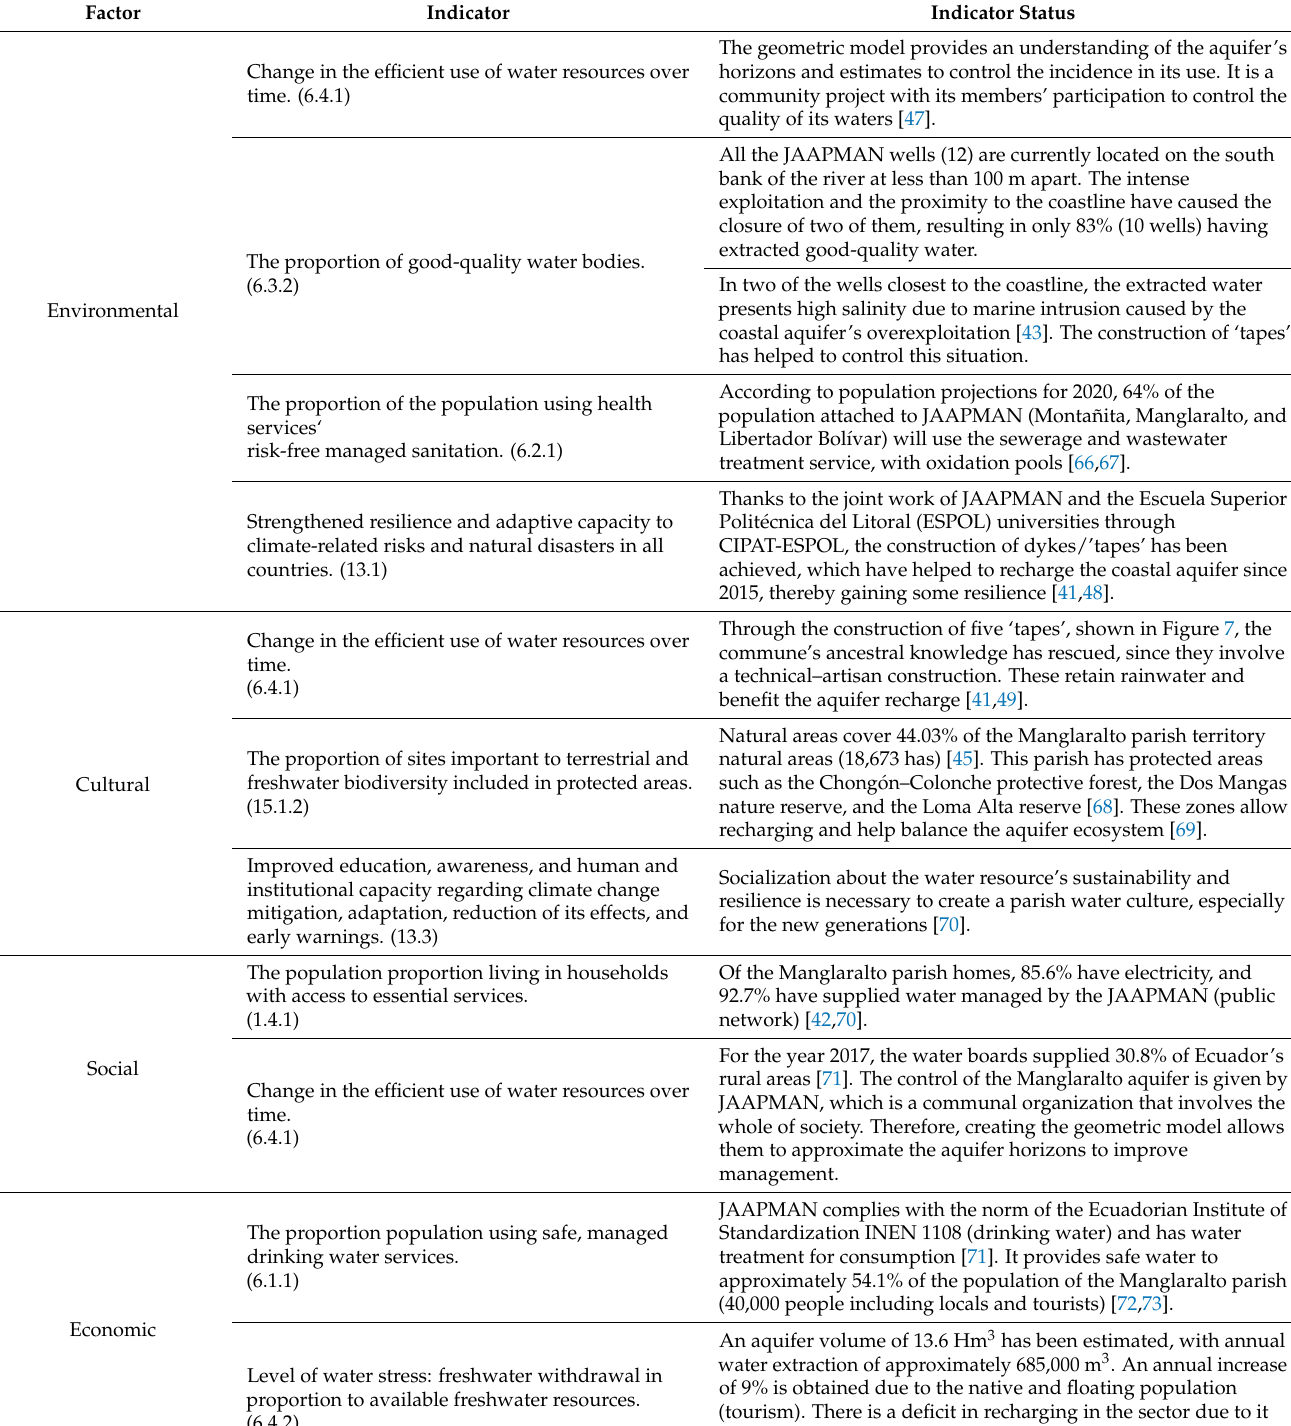
Table 5. Analysis matrix of indicators of the sustainable development goals (SDGs) of the Agenda 2030 for environmental, economic, cultural, and social